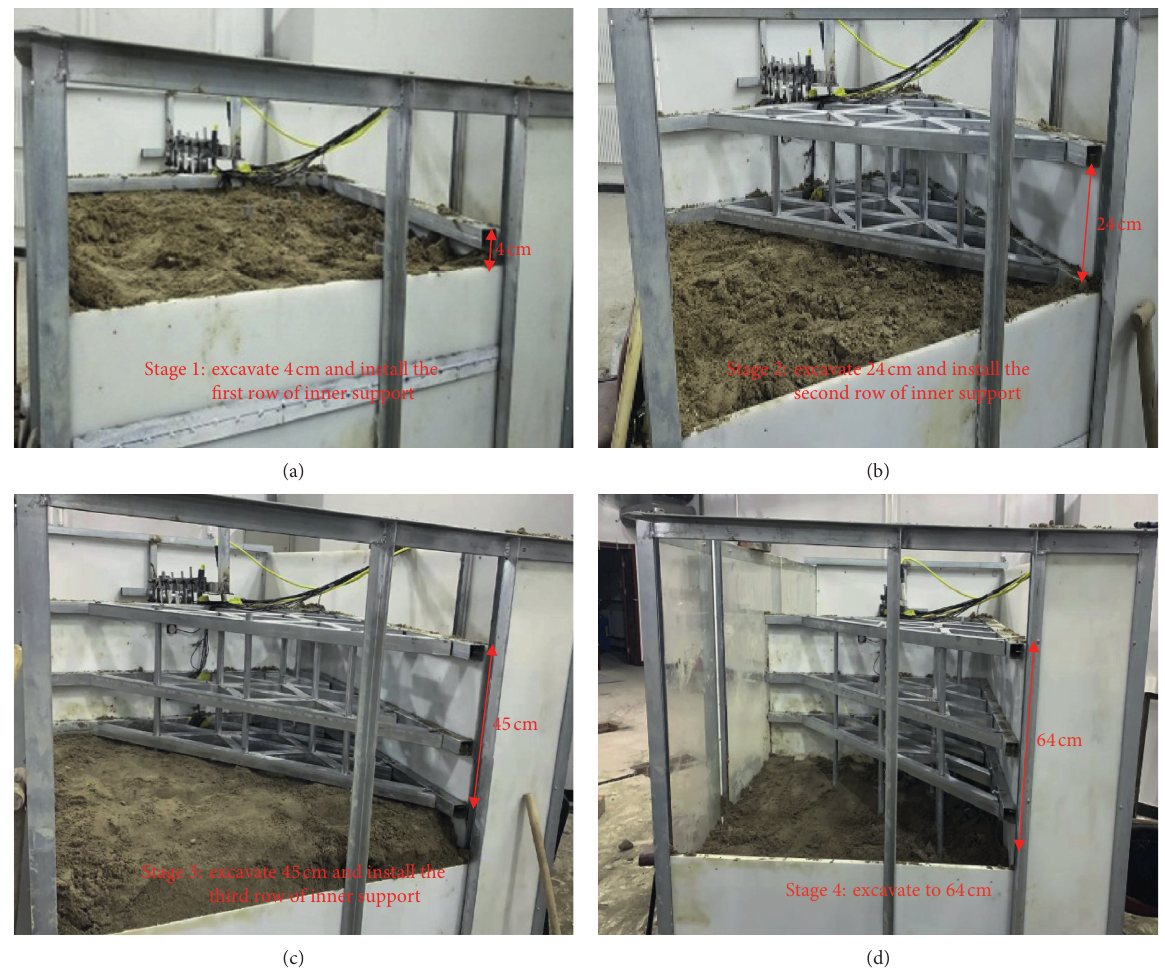
Figure 7: Excavation stage of foundation pit. (a) Stage 1. (b) Stage 2. (c) Stage 3. (d) Stage